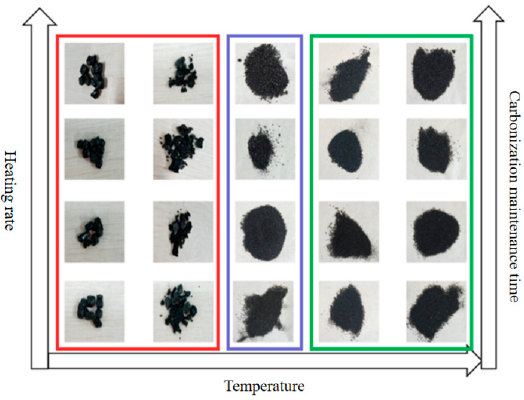
Figure 6. The morphology of the carbonized product.